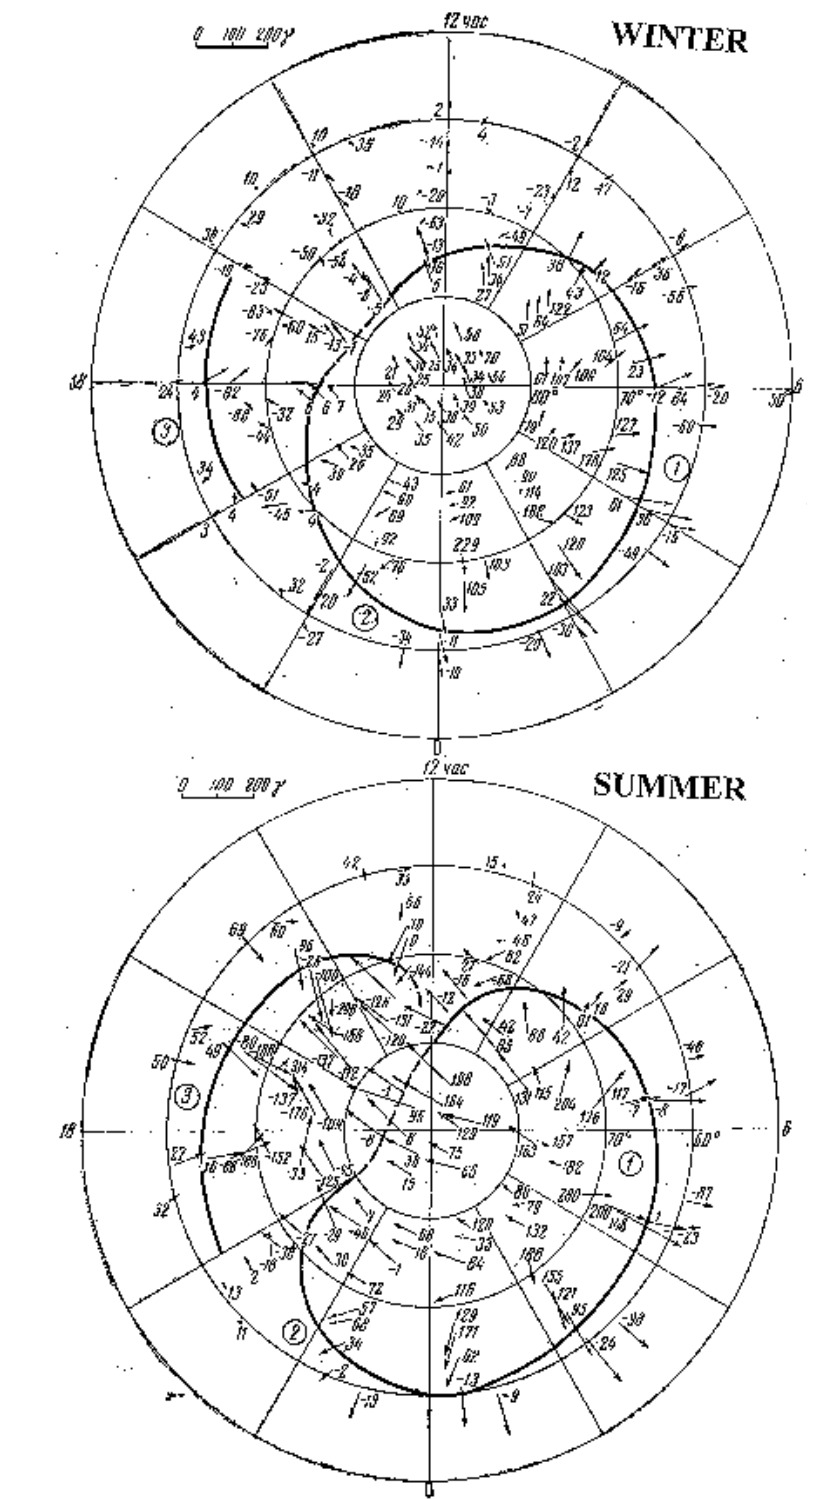
Figure 3. Loci of maximum intensity ∆ T and minimum ∆ Z fields in LMT versus corrected geomagnetic latitudes in Northern Hemisphere. The digits 1, 2, and 3 correspond to morning, nighttime, and evening spirals, respectively (Feldstein and Zaitzev, 1965a). (a) Winter season of IGY (upper panel) and (b) summer season of IGY (lower